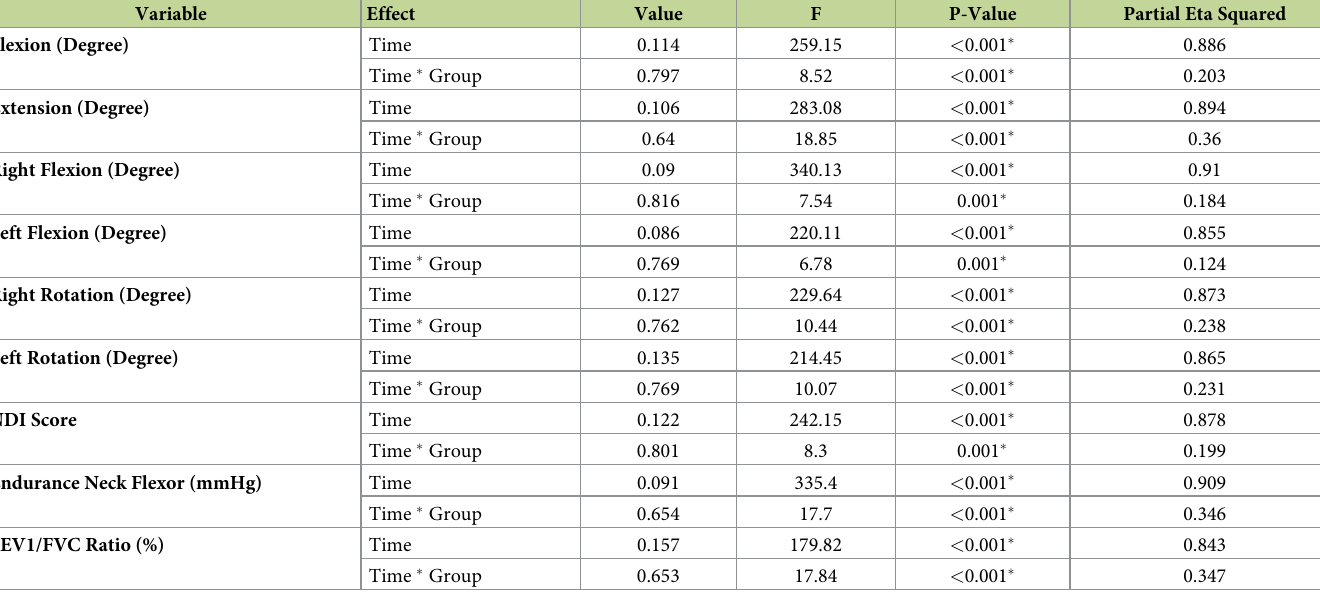
Table 3. Main effect of time (Baseline, 4 th week and 8 th week) and interaction (Time � Group) for symmetric variables.